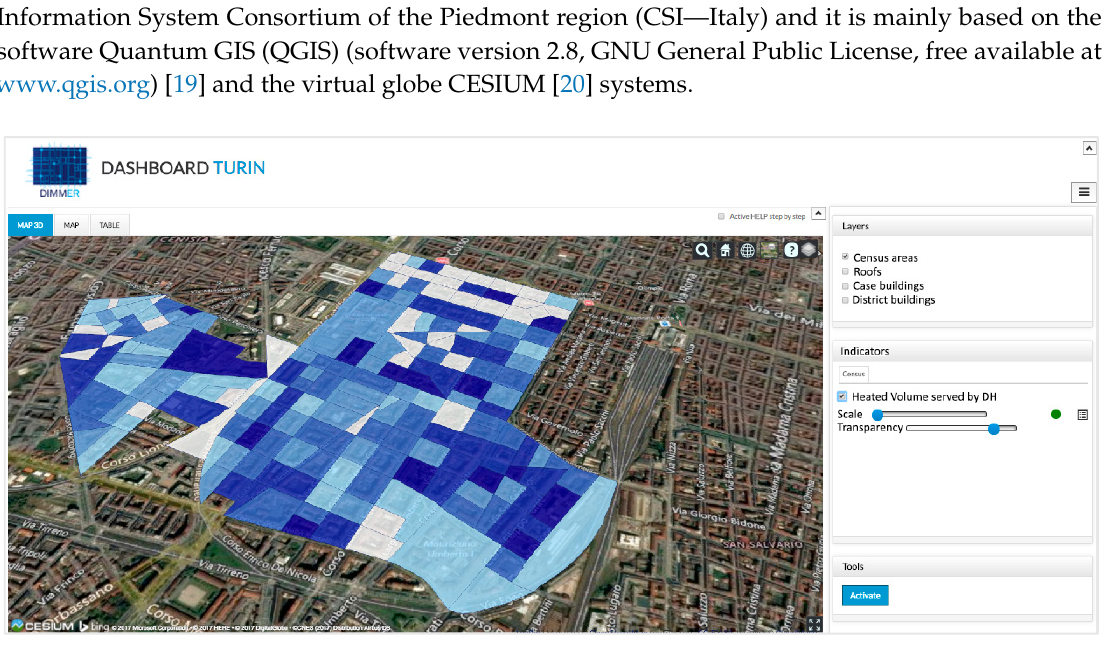
Figure 1. The Dashboard interface.